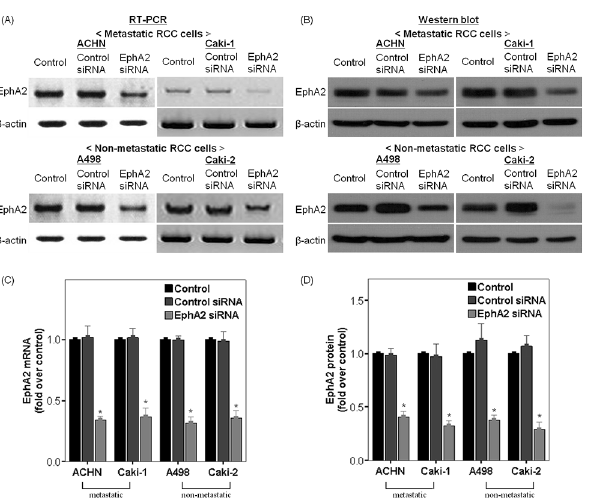
Fig 2. Effect of transfection with EphA2 siRNA on EphA2 expression in RCC cells. Representative RT-PCR (A) and corresponding immunoblots (B) for the comparison of EphA2 expression among the three groups in each cell line. The results were normalized by β -actin expression and presented as fold changes over controls (C and D). * p < 0.05 vs. control and control siRNA treated groups. siRNA = small interfering RNA, RT-PCR = Reverse transcription polymerase chain reaction, RCC = renal cell carcinoma.